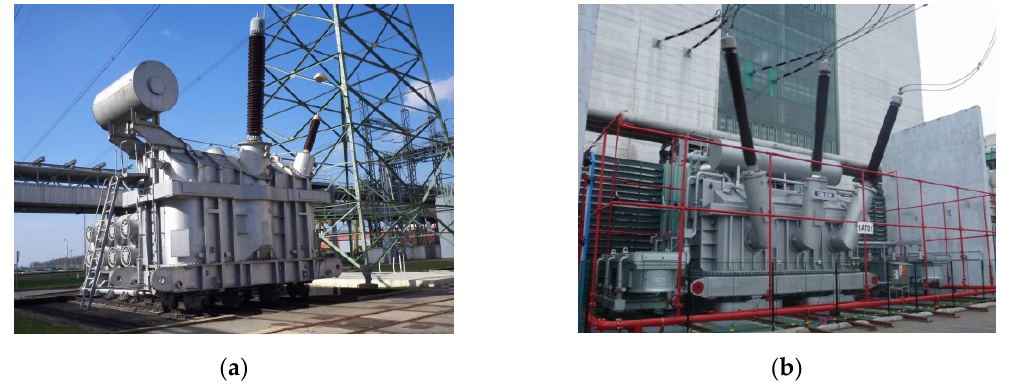
Figure 1. Examples of high-power main transformers: a single-phase 24/420 kV unit, 400 MVA ( a ); a three-phase 16/420 kV unit, 300 MVA ( b ).